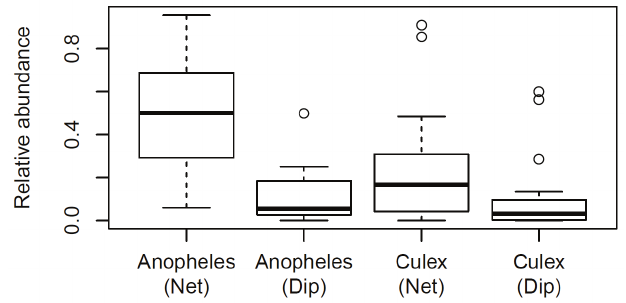
Figure 1. Box plot representations of relative abundance of mosquito specimens grouped by genus per collection. Each collection constitutes a ten minute long sweep net and a ten minute long